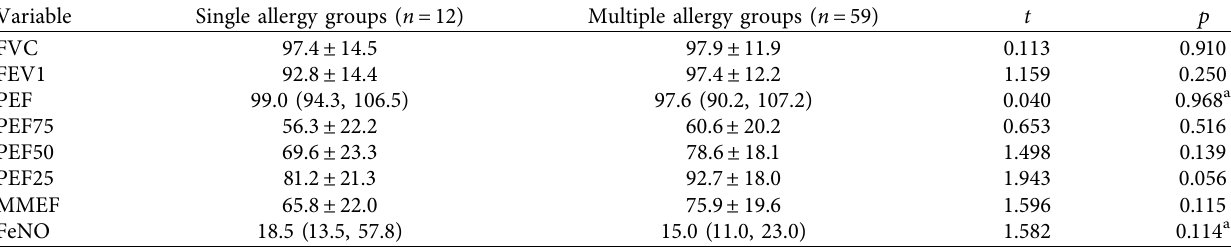
Table 9: Comparison of pulmonary function and FeNO between single allergy groups and multiple allergy